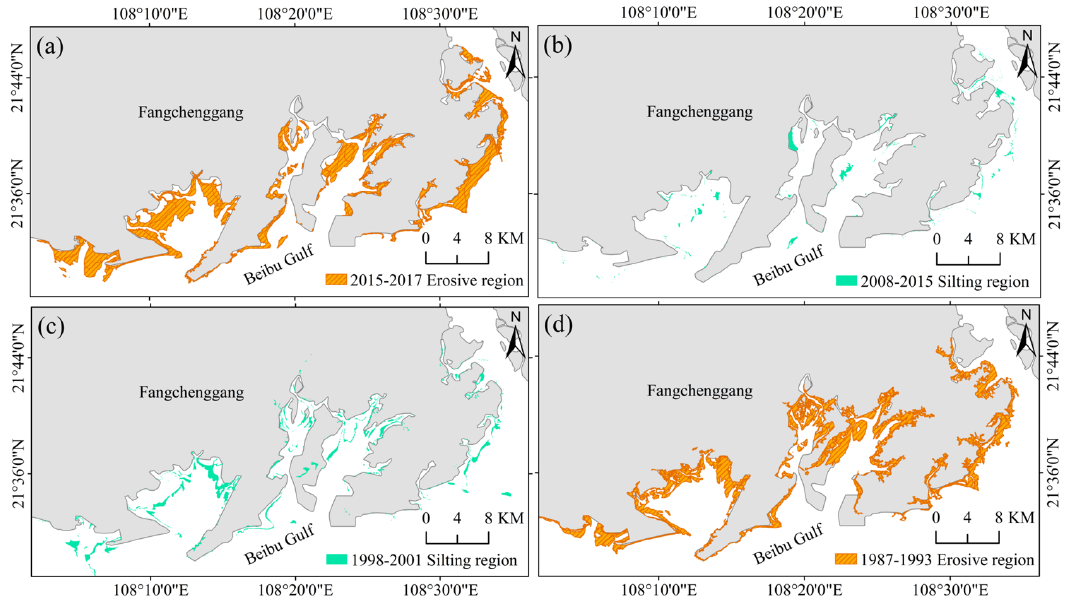
Figure 14. Spatio-temporal siltation erosion distribution of tidal flats in Fangchenggang shore section. ( a ) Erosion distribution of tidal fl ats in Fangchenggang shore section from 2015 to 2017. ( b ) Siltation distribution of tidal fl ats in Fangchenggang shore section from 2008 to 2015. ( c ) Siltation distribution of tidal fl ats in Fangchenggang shore section from 1998 to 2001. ( d ) Erosion distribution of tidal fl ats in Fangchenggang shore section from 1987 to 1993.